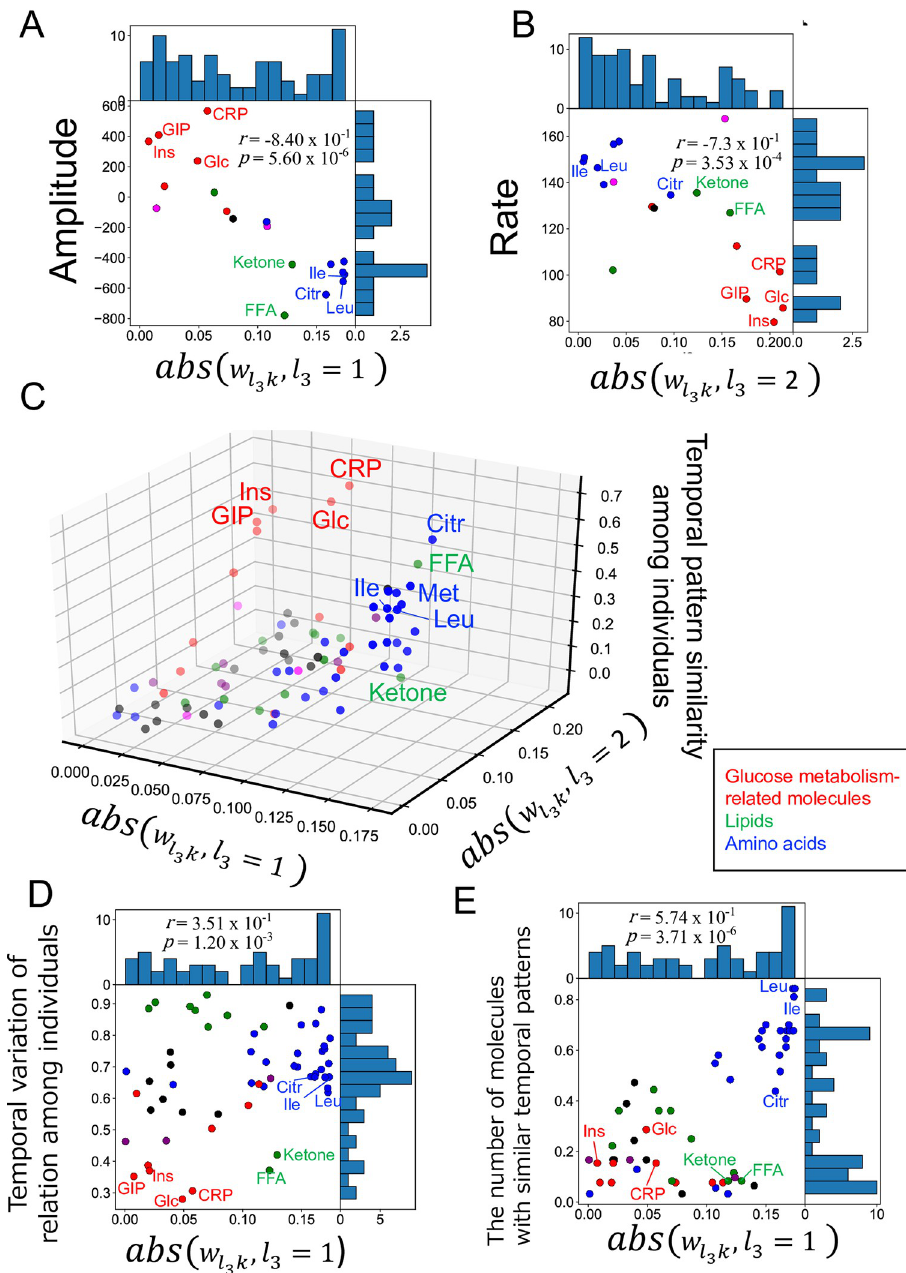
Fig 4. Comparison of tensor decomposition analysis with hypothesis-driven analysis. A The distribution of abs ( w ; l ¼ 1 ) and magnitude of response for each molecule. B The distribution of abs ( w 3 l 3 k response for each molecule. C The distribution of abs ( w pattern among individuals for each molecule. D The distribution of abs ( w relationship among individuals over time for each molecule. E The distribution of abs ( w molecules with similar temporal pattern for each molecule. Dot colors correspond to the metabolic groups (inset). Representative molecules are labeled. Their abbreviations are as follows: Cit, citrulline; CRP, C-reactive peptide; FFA, free fatty acid; GIP, gastric inhibitory polypeptide (active); Glc, glucose; Ile, isoleucine; Ins, insulin; Ketone, total ketone bodies; Leu, leucine.